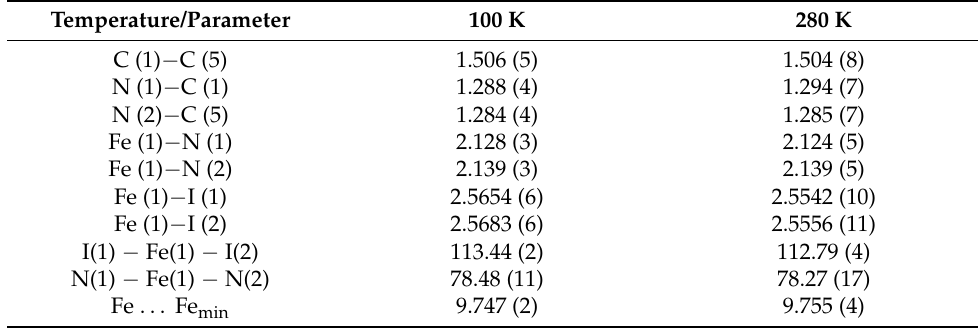
Table 2. Selected bond lengths (Å) and angles ( ◦ ) in 1